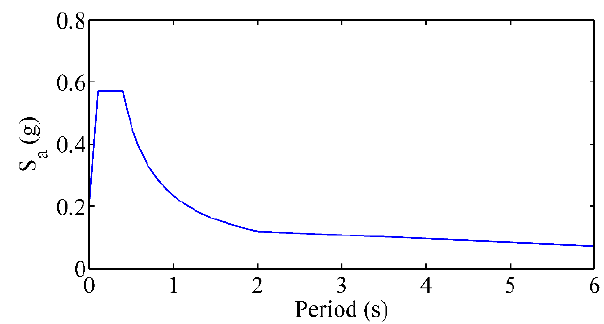
Figure 4. The design response spectrum of the Fujian area.